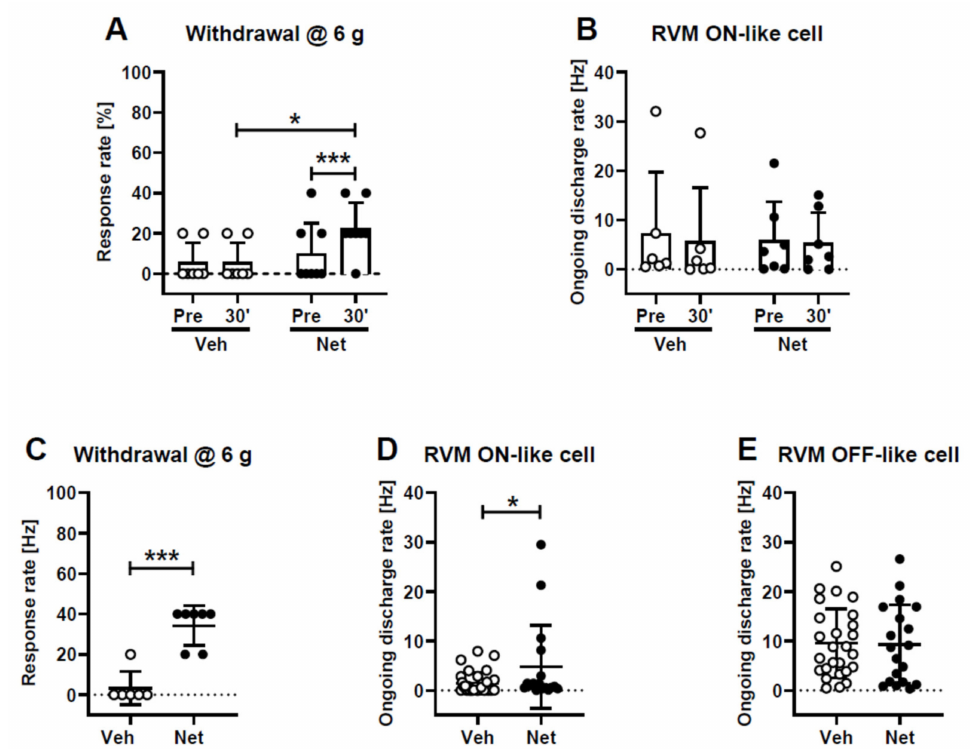
Figure 4. Acute ( A , B ) and chronic ( C – E ) effects of intrathecally-administered netrin-1 (Net, 2.0 µ g) or vehicle (Veh) on mechanical sensitivity ( A , C ) and the response rates of presumably pronociceptive ON-like and antinociceptive OFF-like neurons in the rostral ventromedial medulla (RVM; B , D , E ). In the upper graphs, effect of netrin-1 was studied before (Pre) and 30 min after its administration, whereas the lower graphs represent results obtained three weeks after treatment. The graphs show mean results and the error bars represent S.D. * p < 0.05, *** p < 0.005 (in ( A ), t -test with a Bonferroni correction; in ( C ), unpaired t